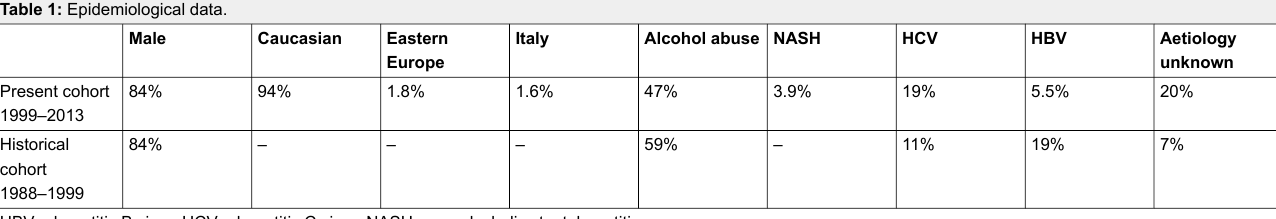
Table 1: Epidemiological